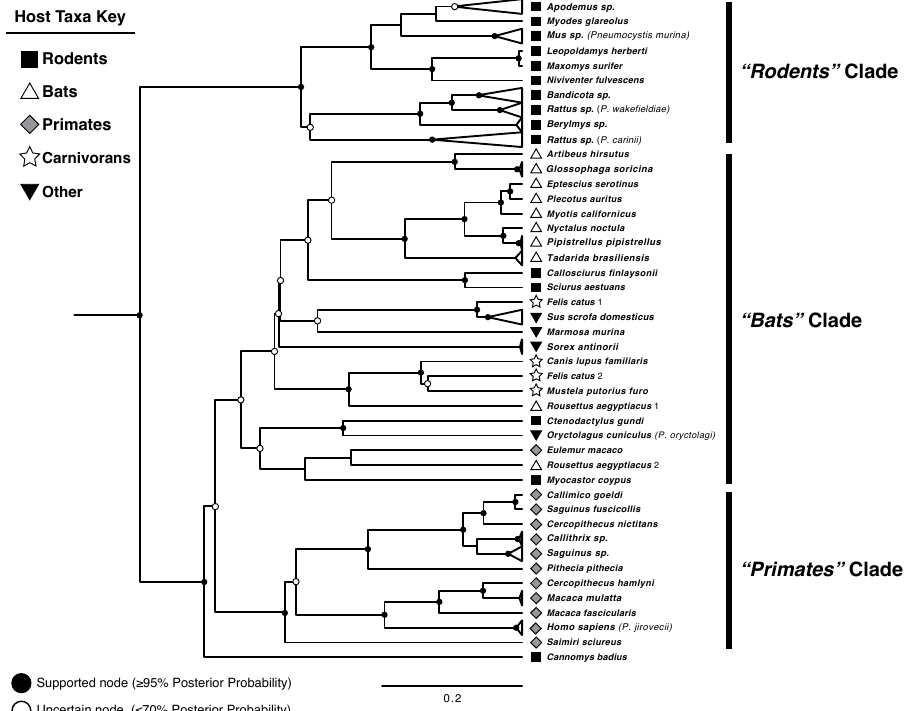
Figure 1. Topology of Pneumocystis from 55 host species recovered by BEAST analysis of concatenated mtLSU and mtSSU sequences. Sequences collected from the same host genus are collapsed where they are monophyletic for viewability, represented by triangles at branch ends. Highly supported and highly uncertain nodes are marked; unmarked nodes have posterior probabilities between 70% and 95%. Tip labels refer to the name of the host, with Pneumocystis species names included in brackets where sequences in the lineage were identified as belonging to a described